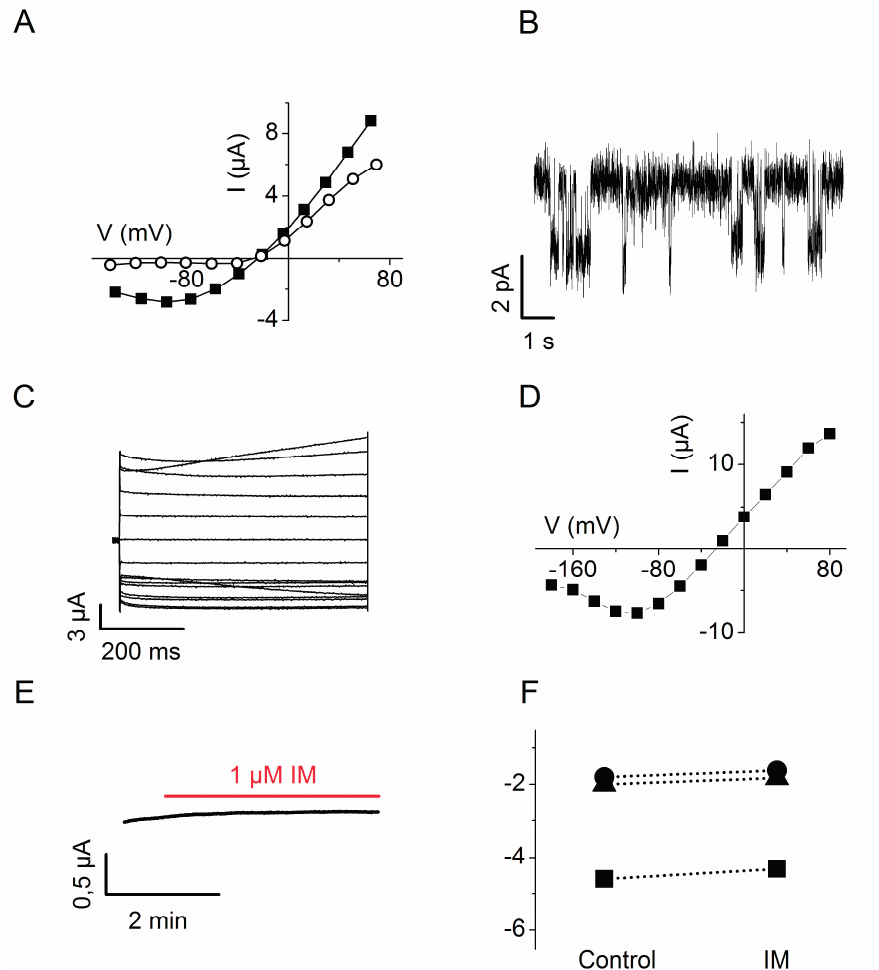
Figure 4. Characterization of Chimera 2 wt and properties of Chimera 2-CaM-mutated. ( A ) I/V curve of Steady State whole-cell currents recorded from the Chimera 2 in the presence of IM, before (solid square) and after (open circle) the addition of 1 mM barium in the external medium; ( B ) Single channel recording of Chimera 2 at − 60 mV; ( C ) Properties of Chimera 2-Cam-mutated: whole-cell macro currents recorded with TE-Voltage Clamp; ( D ) I/V curve of steady state macro currents of Chimera